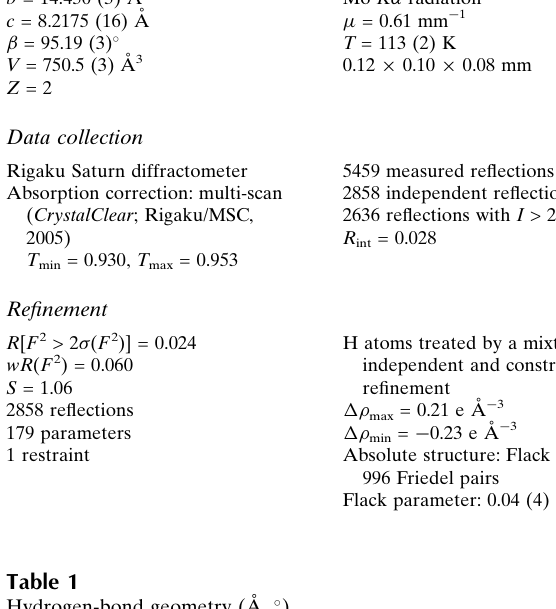
Rigaku Saturn diffractometer Absorption correction: multi-scan